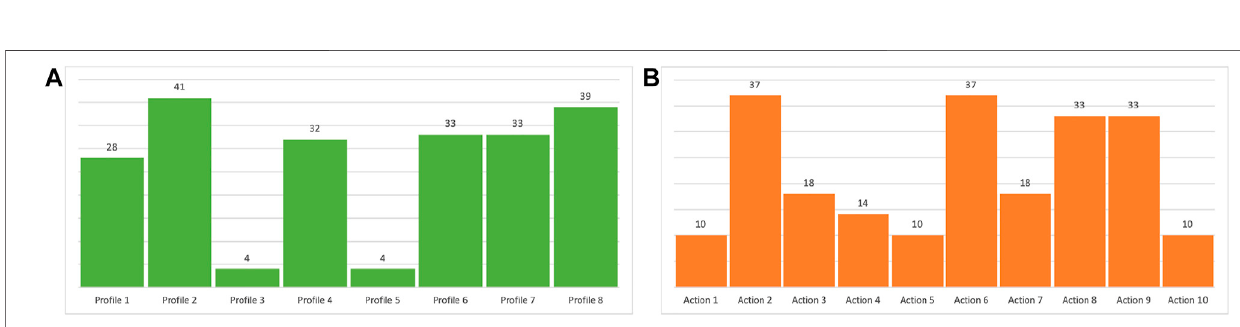
Frontiers in Robotics and AI |